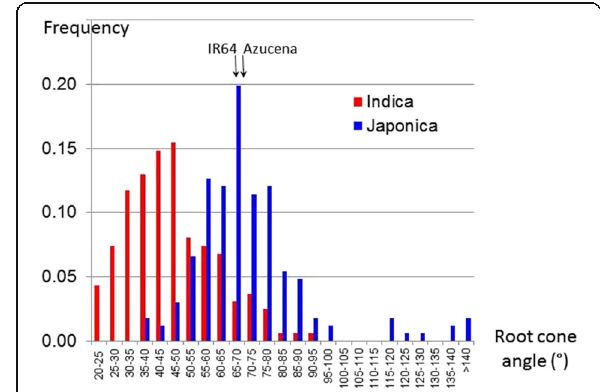
Fig. 3 Distribution of the root cone angle (°) for the indica (red) and japonica (blue) panels